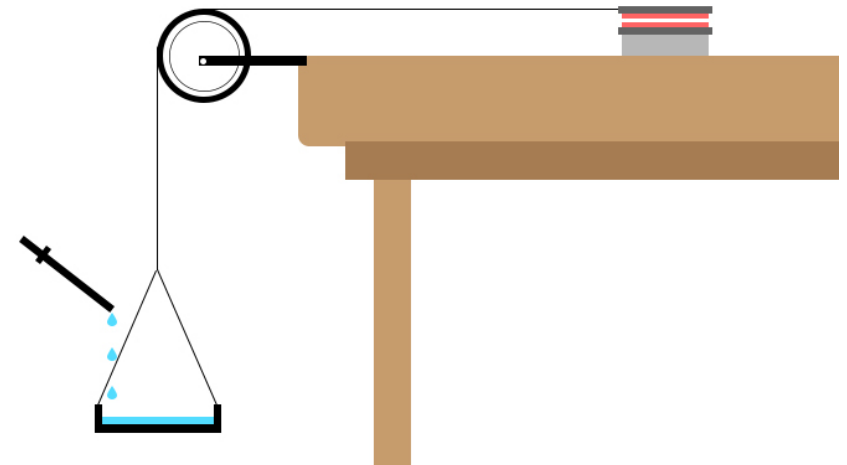
Figure 4. Simulation of estimation of ex vivo mucoadhesive drag force.